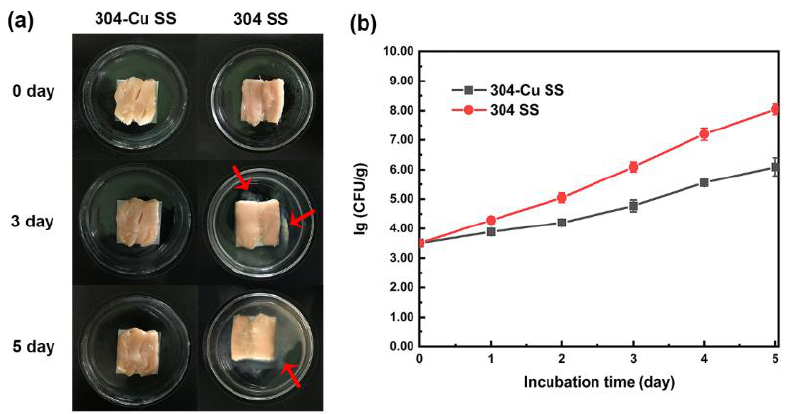
Figure 7. ( a ) Sensory changes in chicken meat spread out on antibacterial 304-Cu and ordinary 304 stainless-steel sheets, respectively; red arrows indicate the areas where the mucus obviously overflowed. ( b ) Changes in total bacterial count of chicken spread out on antibacterial 304-Cu and ordinary 304 stainless-steel sheets [79]. Table 1. Changes in electrical conductivity and TVB-N of chicken meat spread out on antibacterial 304-Cu and ordinary 304 stainless-steel sheets [79].